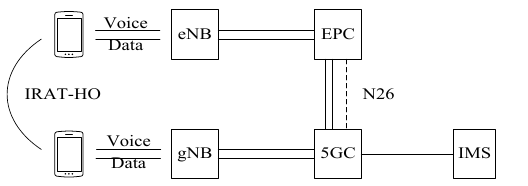
Figure 7. Voice over NR (VoNR) architecture under stand-alone (SA) networking.